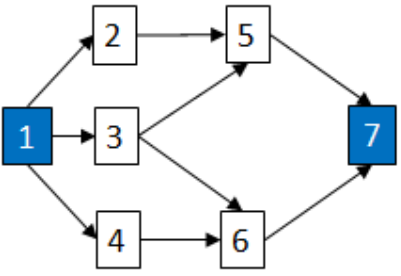
Figure 4. RBD of an example network